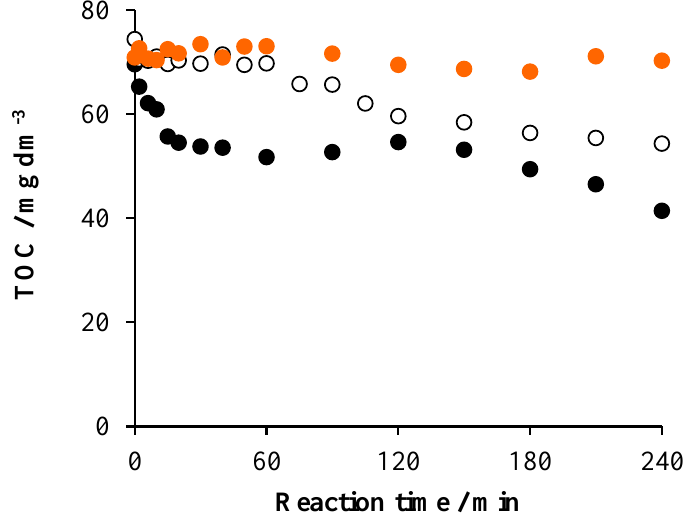
Figure 7. The change of TOC as a function of the reaction time under various conditions in the system containing 2 × 10 −4 mol·dm −3 Triton X-100 and 10 −3 mol·dm −3 Na 2 S 2 O 8 : air (•), air/UV (○), air/UV/TiO 2 (1 g dm −3 )